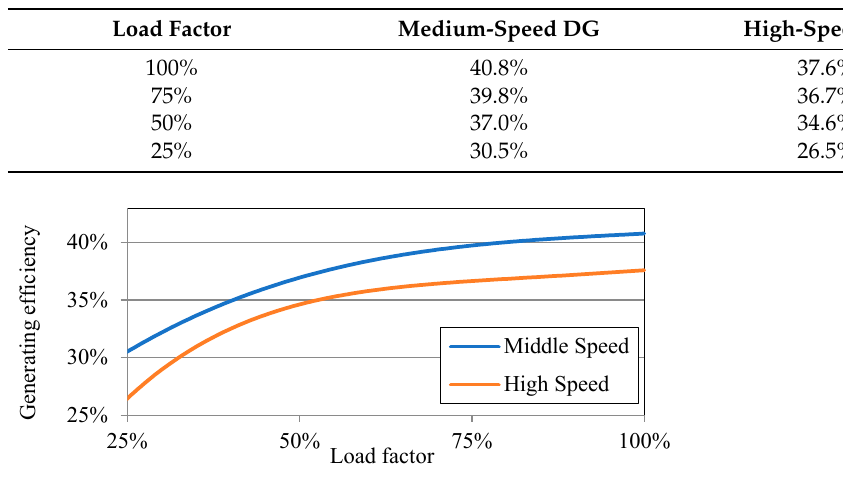
Table 1. Representative values of efficiency of DGs.